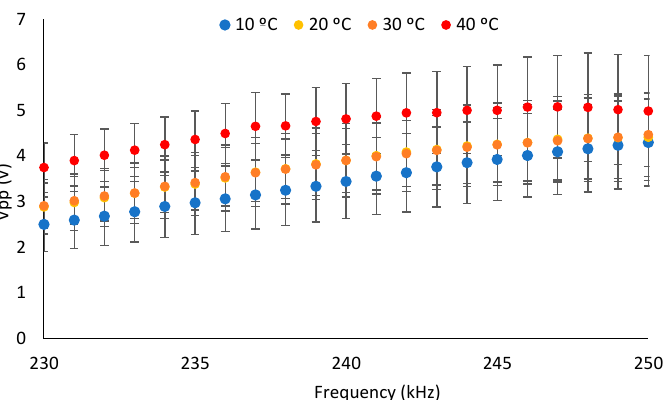
Figure 8. Vpp for the selected frequencies according to the pH value. Data include the repetitions performed for the different temperatures.